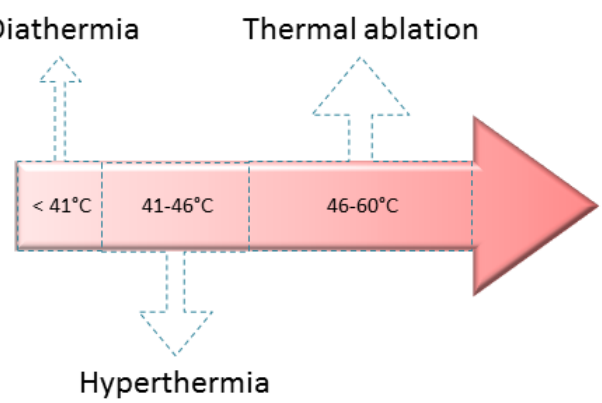
Figure 8. Most commonly employed heating medical treatments.